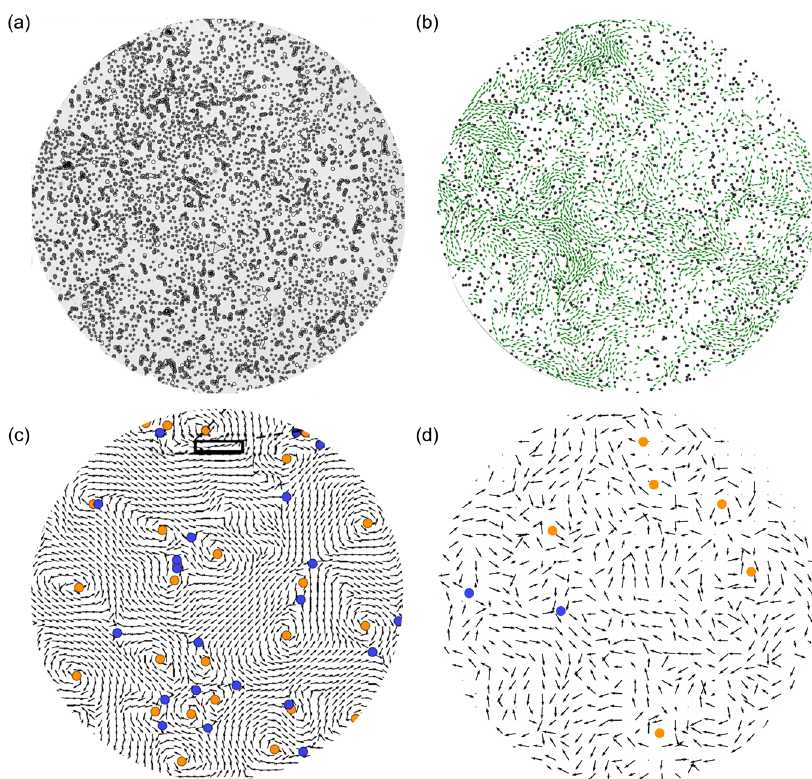
Fig. 2 Behaviour of our model. The model is compared with ref. 29 . a , b show frames from the movies of the motion and c , d show the corresponding velocity fi elds, where ( a ) and ( c ) are from ref. 29 (reproduced with permission of the authors), and ( b ) and ( d ) were obtained during our simulations. In panel ( b ), the green dots are particles, and the black ones are obstacles. The blue and yellow circles in ( c ) and ( d ) denote topological defects in the velocity fi eld. This comparison demonstrates that our model is able to reproduce the “ meander ” state of motion discovered experimentally by Chardac et al. 29